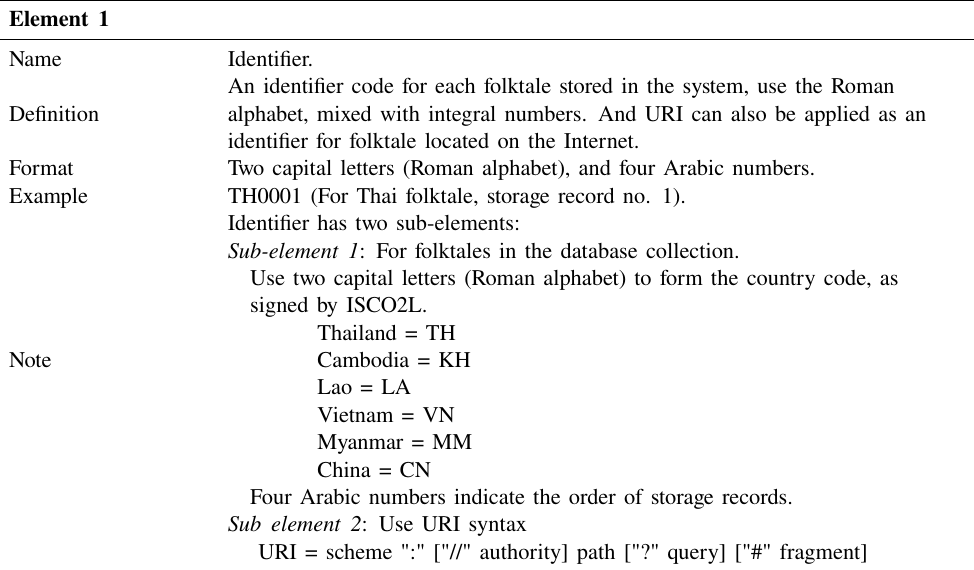
Table 1. Description of data elements in metadata for folktales in the